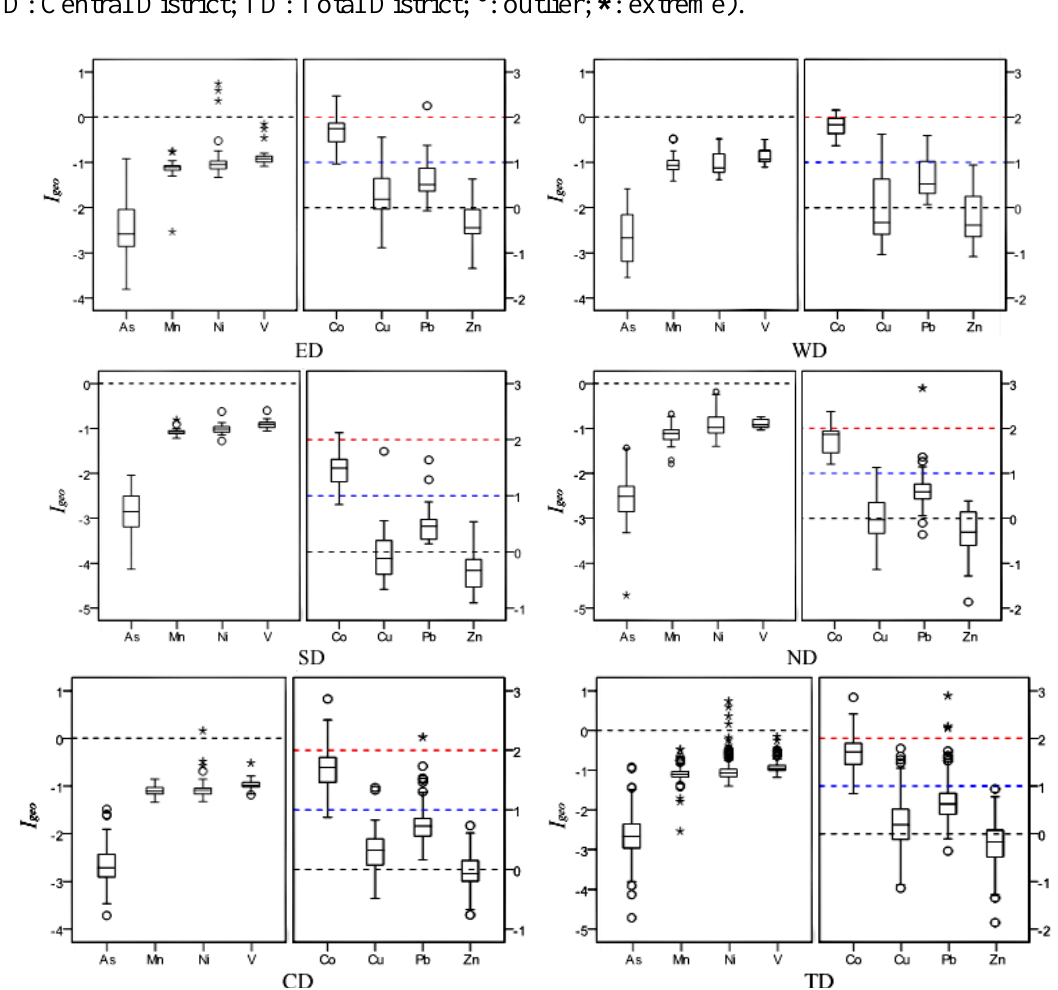
Figure 4. Box-plots of I for ESEs in smaller than 100 μm street dust particles from geo